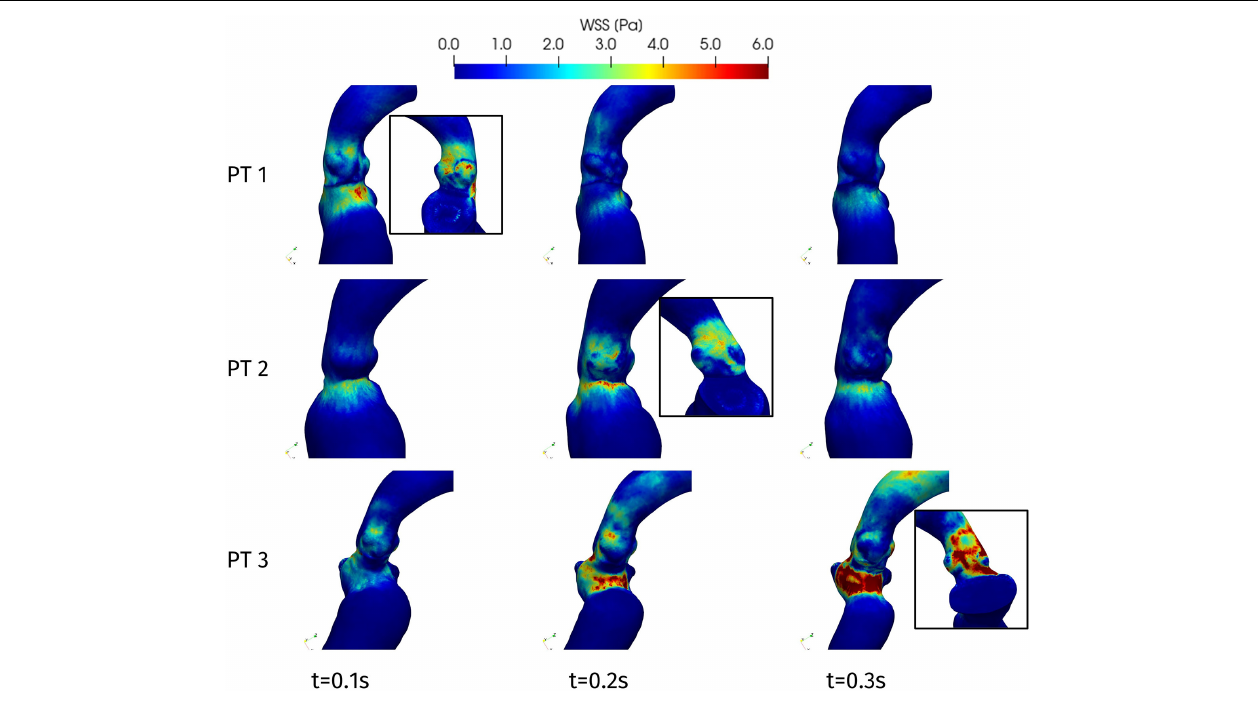
FIGURE 11 | Wall shear stress distributions at significant times during systole: view from the interventricular septum. In the boxes, WSS distribution on the aortic root wall at the systolic peak (view from the atrial side): Patient 1, t = 0.08 s; Patient 2, t = 0.23 s; and Patient 3, t = 0.20 s.